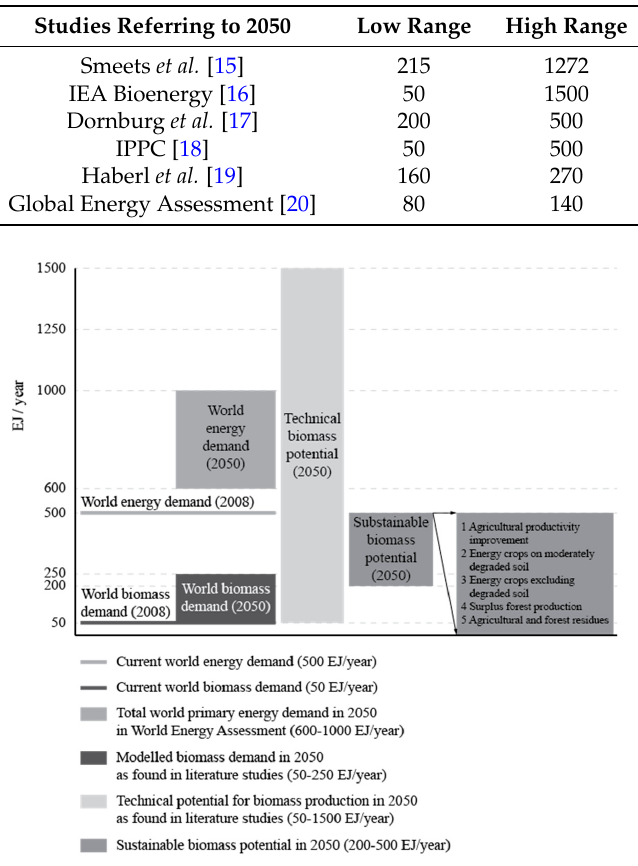
Figure 4. Global bioenergy sources [14].